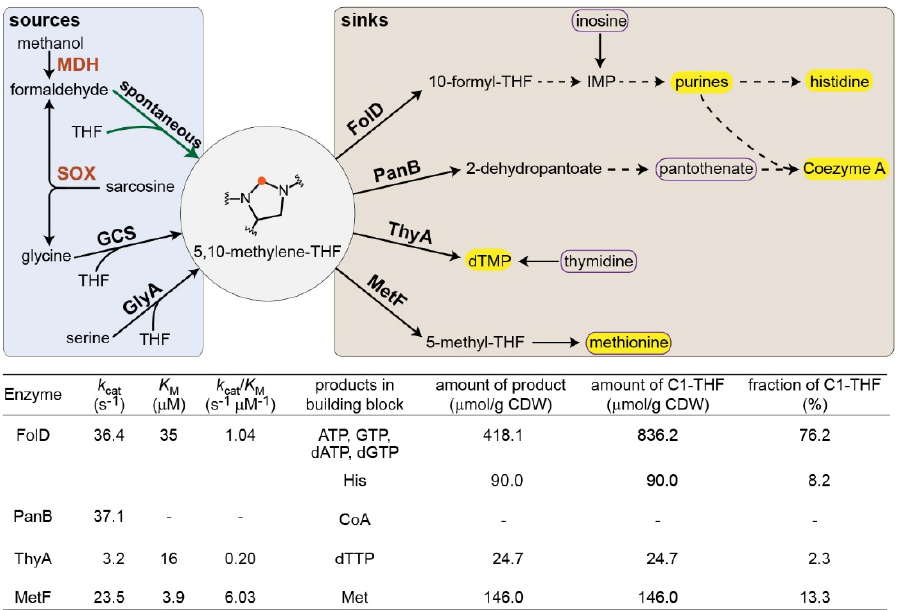
Figure 1. Metabolic sources and sinks for 5,10-methylene-THF. C 1 -derived biomass building blocks are shown within yellow frame, while compounds added to the medium to relieve the C 1 auxotrophy are shown within a purple box. GCS corresponds to the glycine cleavage system. Formaldehyde is produced via the activity of either methanol dehydrogenase (MDH) or sarcosine oxidase (SOX). The kinetic parameters of the enzymes utilizing 5,10-methylene-THF [14–17] are shown together with the metabolic requirements for their products [18].